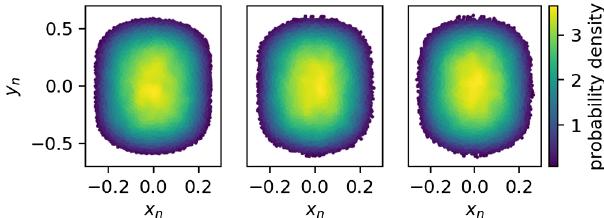
FIG. 21. Projected maximum of Δ beam for T ¼ 256